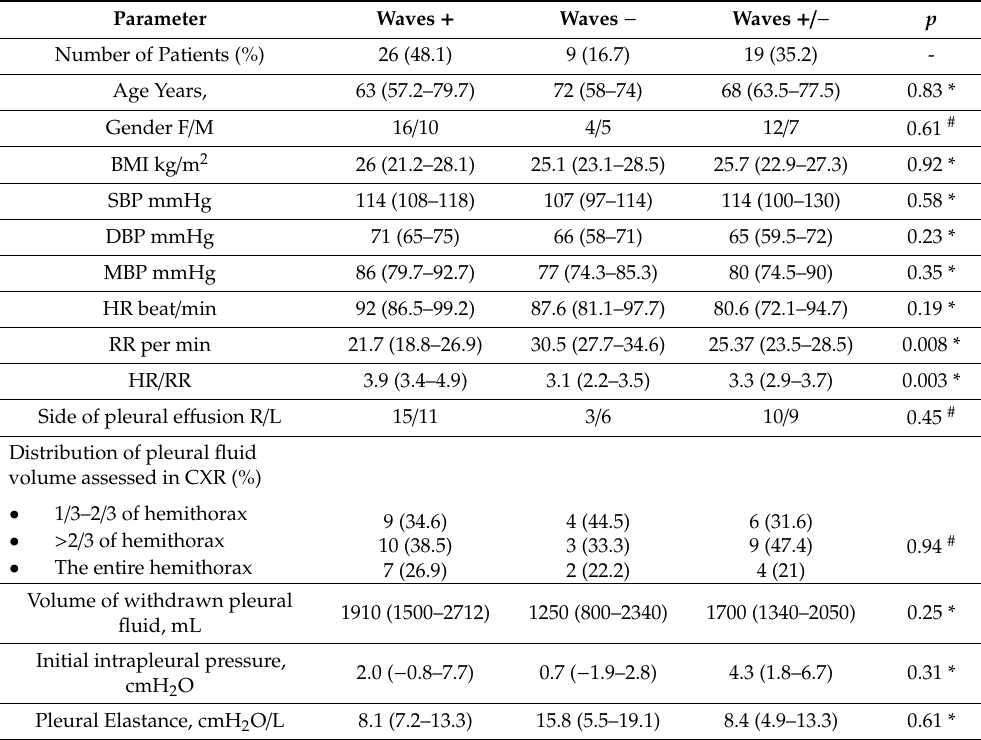
Table 1. Comparative characteristics of baseline parameters and data on thoracentesis in patients with well visible, poorly visible, and undetectable pulsations. Data are presented as numbers and percentages or medians and IQRs.